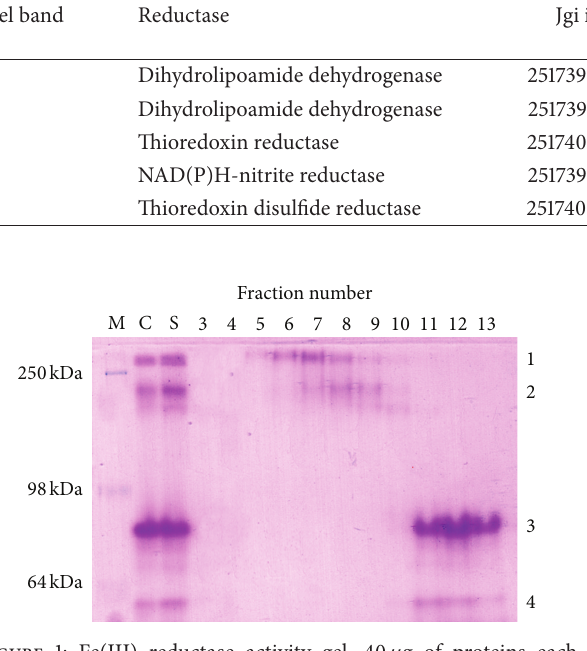
Figure 1: Fe(III) reductase activity gel. 40 𝜇 g of proteins each from crude cellular extract (lane 1) and soluble fraction (lane 2) was resolved by 10% nondenaturing PAGE. The soluble fraction concentrated by ammonium sulfate precipitation (30 to 80%) was applied to a Superdex 200 gel filtration column. Three micrograms of proteins each from fractions 3–13 was also electrophoresed in the same gel. Markers (M) are indicated on the left. Fe(III) reductase activity bands are marked on the